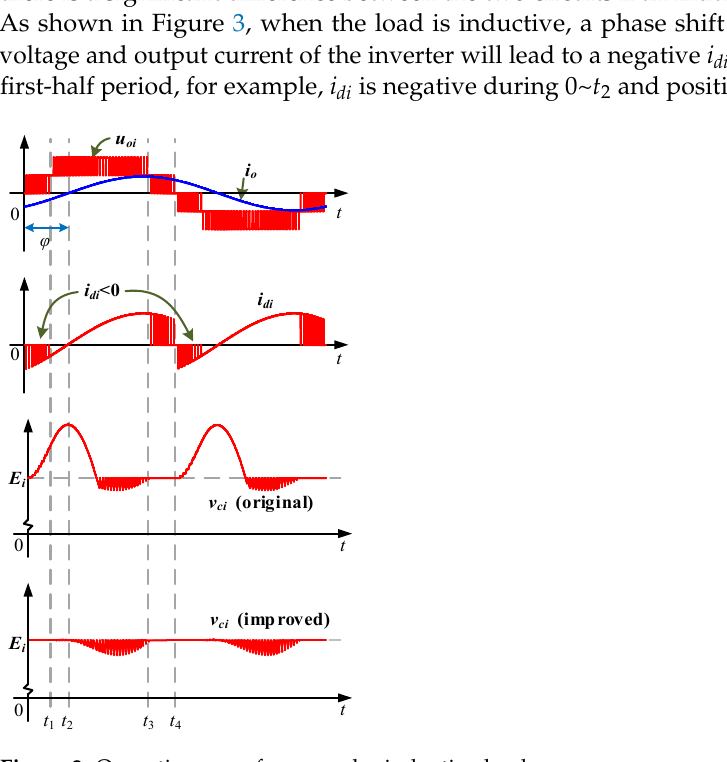
Figure 3. Operation waveforms under inductive load.